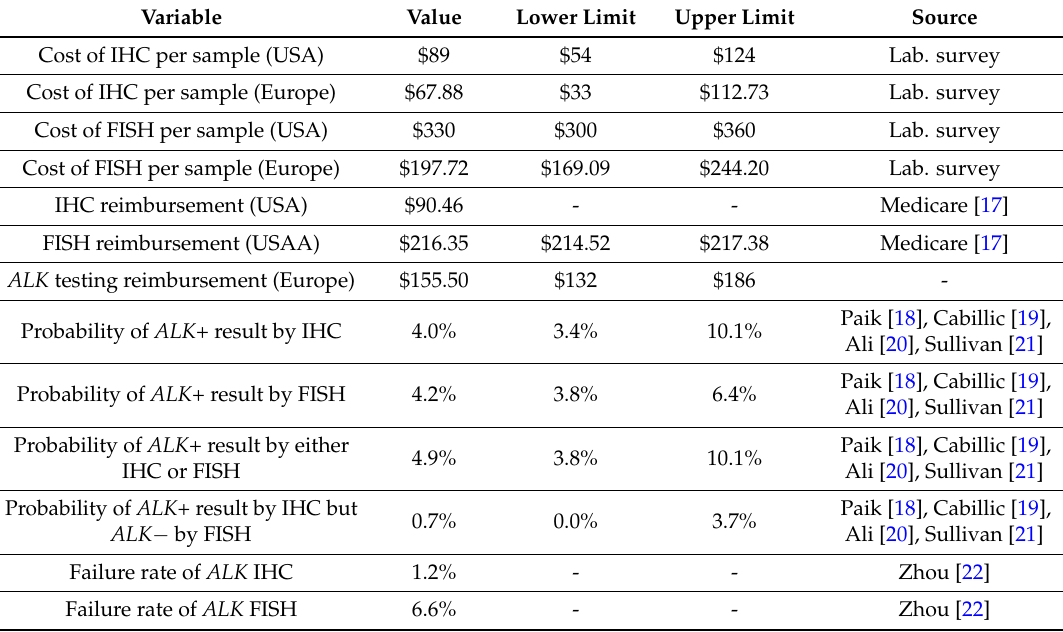
Table 1. Key model parameters for cost-impact model.